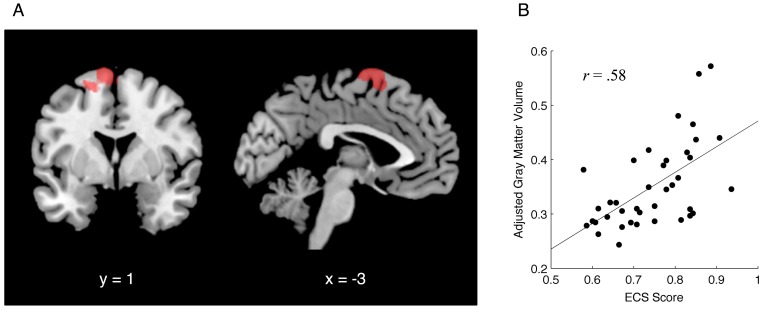
Brain area for which gray matter volume positively correlated with executive function capacity assessed with the Effortful Control Scale (ECS).The significant cluster (A) was identified based on statistical criteria of P<0.005 at voxel level, with P<0.05 corrected for multiple comparisons at cluster level. At the peak locus (MNI coordinates: x = −3, y = 1, z = 70; BA 6, supplementary motor area), the correlation coefficient between ECS score and gray matter volume, adjusted for age and gender, was 0.58 (B).